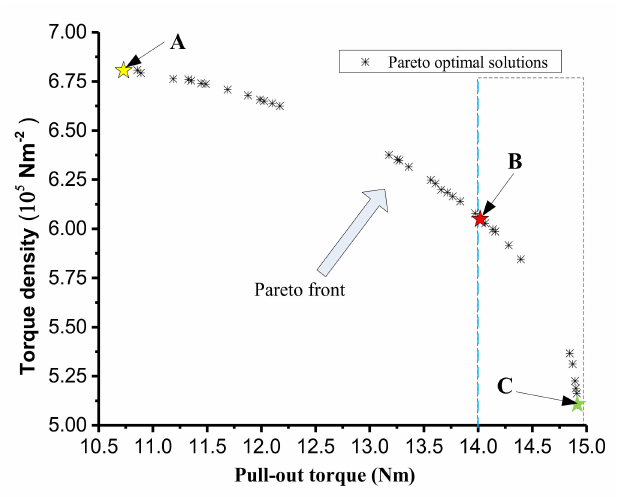
Figure 23. Pareto front of two optimization